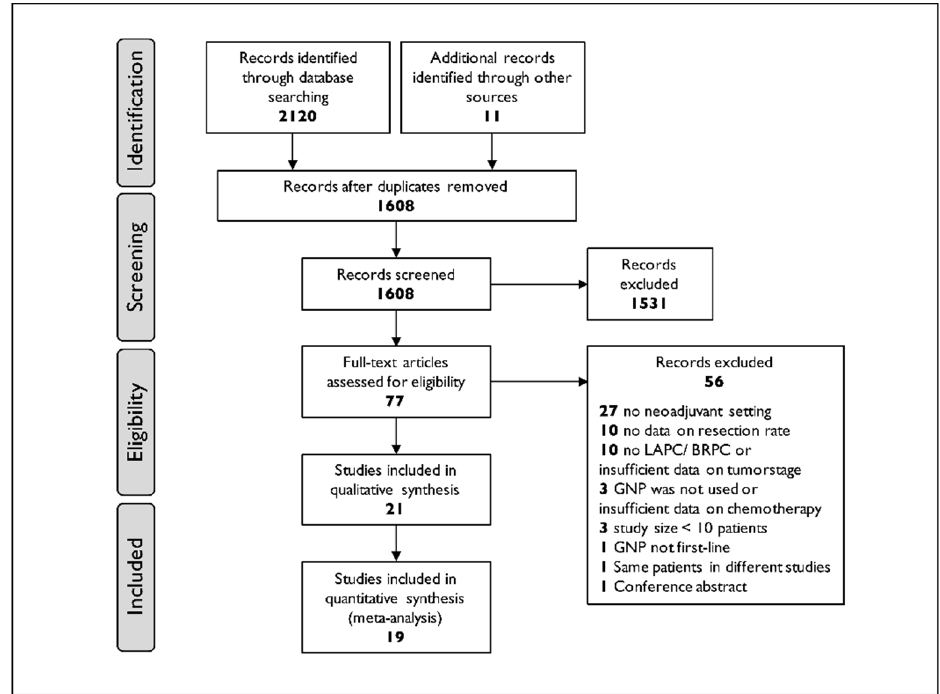
Figure 1. PRISMA flow diagram of the study selection process. After the database search, 1608 publications were screened and 21 studies met the criteria. Abbreviations: LAPC, locally advanced pancreatic cancer; BRPC, borderline resectable pancreatic cancer; GNP, gemcitabine and nab-paclitaxel.